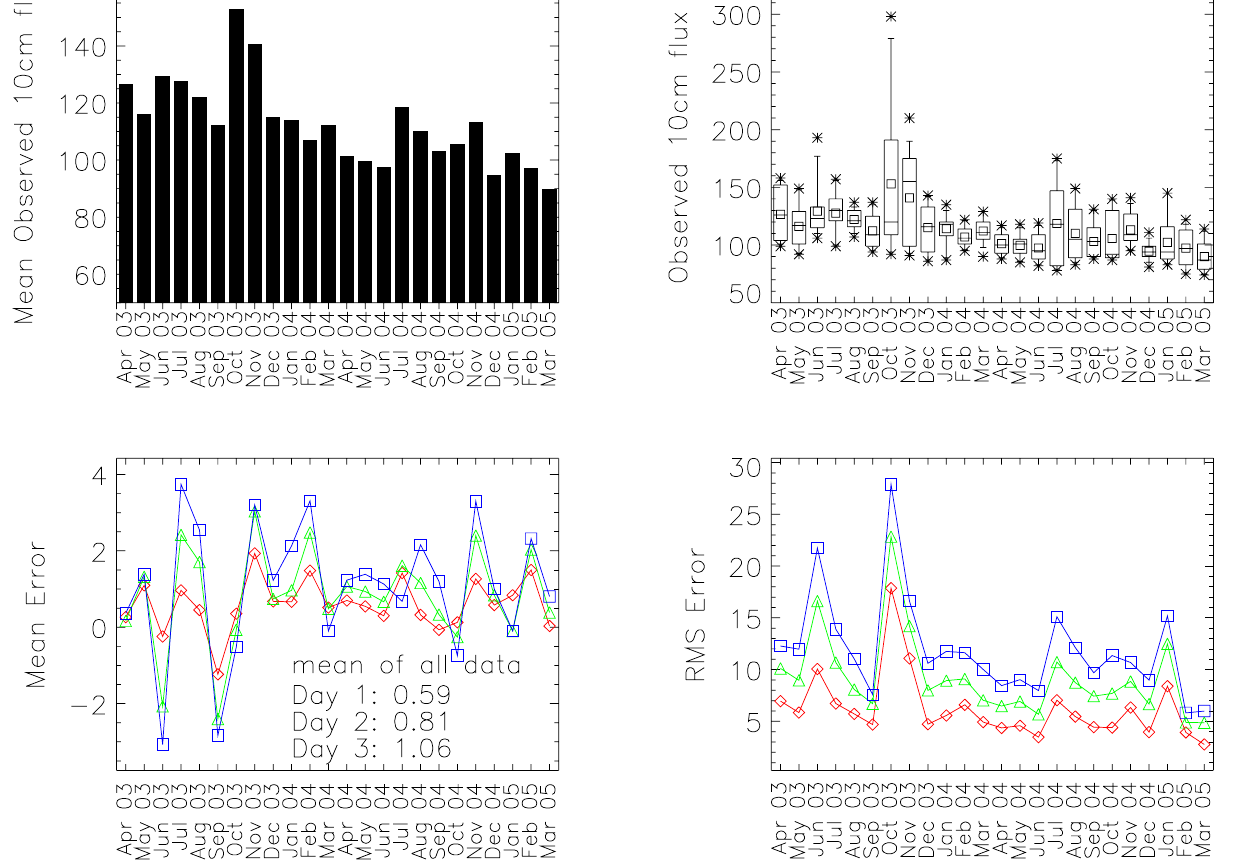
Fig. 12. 10.7cm radio flux forecast. The top left panel shows the mean observed flux for each month. The top right graph is a box plot of the monthly distribution. Stars indicate the minimum and maximum value, the small square the mean observed value and the horizontal line within the box indicates the median. The box contains the observed values from the lower quartile (25%) to the upper quartile (75%) of the distribution. The lower panel concerns the forecast: in the left panel the monthly mean error is plotted, the right panel shows the monthly root mean square error. The red curve represents the forecast for the same day (day 1), the green curve the forecast for the next day (day 2) and the blue curve for two days ahead (day